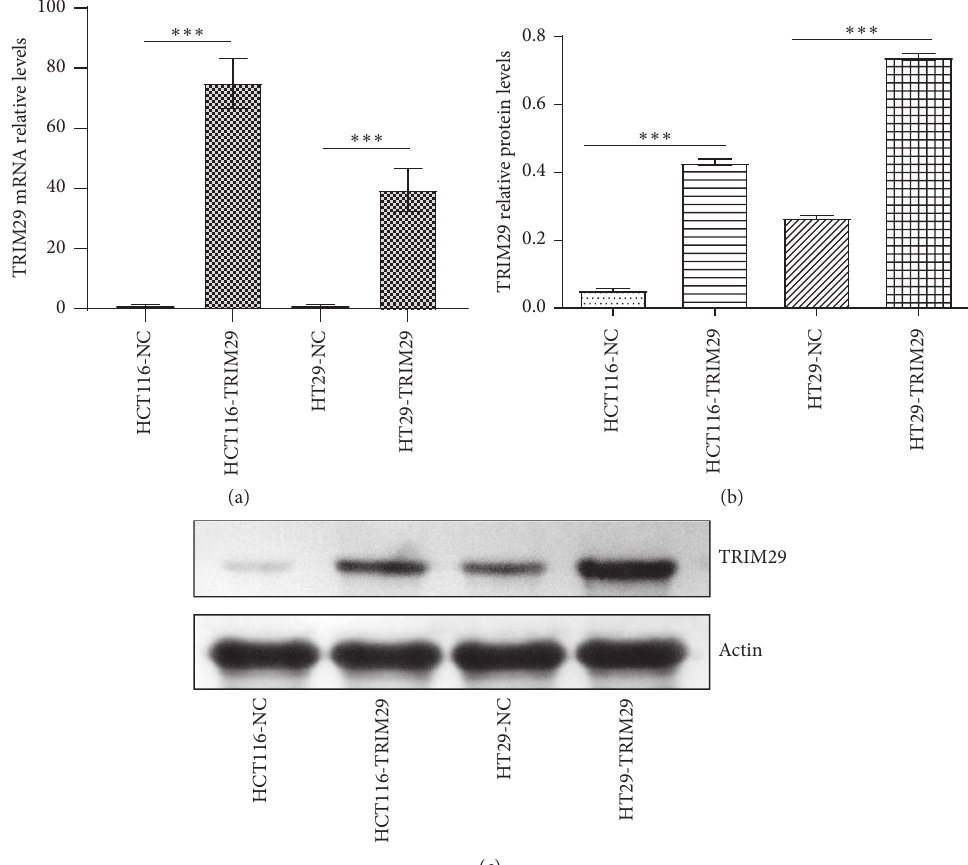
Figure 1: pIRES2-ZsGreen1-TRIM29-flag was successfully transfected into HCT116 and HT29 cells. (a). After transfection with the pIRES2-ZsGreen1-TRIM29-flag plasmid, the mRNA expression of TRIM29 in HCT116 and HT29 cells increased. (b). After transfection with pIRES2-ZsGreen1-TRIM29-flag plasmid, the protein expression of TRIM29 in HCT116 and HT29 cells increased. (c). The Western blot band image of protein expression of TRIM29 in HCT116 and HT29 cells. ∗∗∗ P < 0 . 05. Comparisons among multiple groups were analyzed using one-way